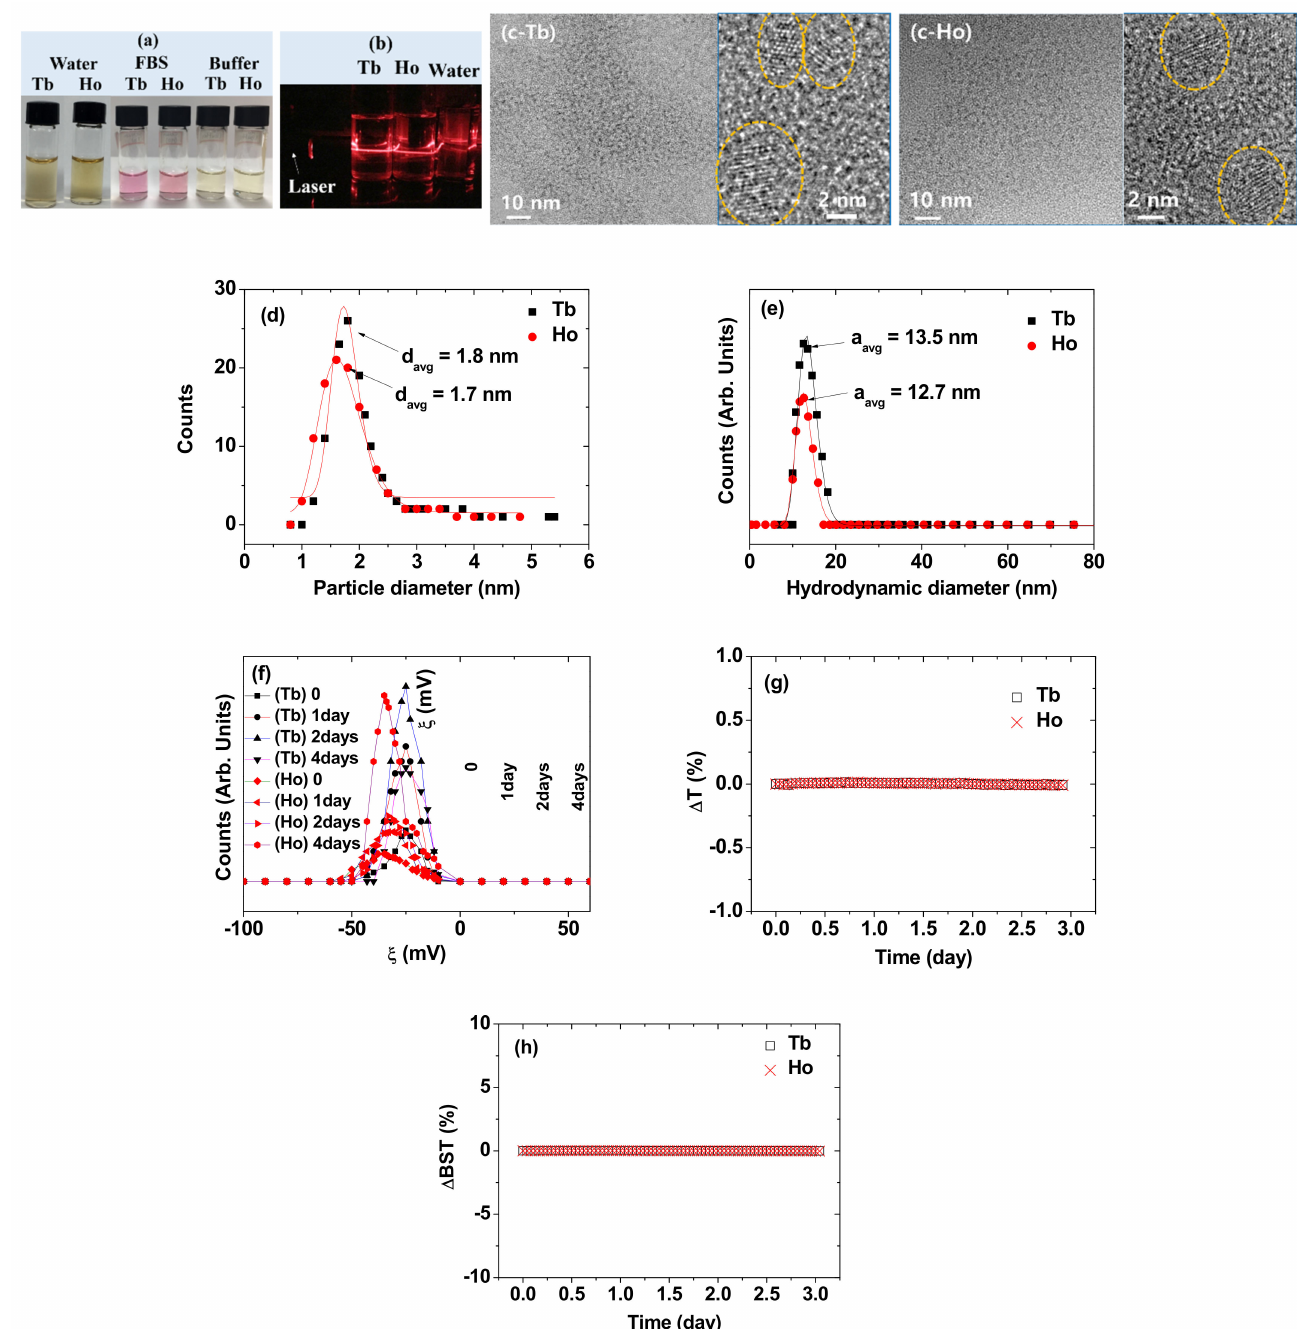
Figure 2. ( a ) Photographs of nanoparticle suspension samples in aqueous media, 10% FBS in RPMI1640 medium, and sodium acetate buffer solution (pH = 7.0), ( b ) laser light scattering (i.e., Tyndall effect) proving NP dispersions: laser light scattering was observed only for both solution samples whereas no light scattering was observed for the reference triple-distilled water, ( c ) HRTEM images at low (10 nm scale) and high (2 nm scale) magnifications: dotted circles indicate the PAA-coated Ln 2 O 3 NPs (Ln = Tb and Ho), ( d ) particle diameter distributions and log-normal function fits (the total number of NPs, N total = 133 for PAA-coated Tb 2 O 3 NPs and 111 for PAA-coated Ho 2 O 3 NPs), ( e ) hydrodynamic diameter distributions and log-normal function fits, ( f ) plots of zeta potentials ( ξ ) overtime (0, 1, 2, and 4 days) [insets are plot of ξ versus time (t)], ( g ) plots of ∆ T [= T(t) − T(0); T = height-averaged transmission of NIR beam] as a function of time, and ( h ) plots of ∆ BST [= BST(t) − BST(0); BST = height-averaged backscattering of NIR beam] as a function of time. Labels “Tb” and “Ho” indicate the PAA-coated Tb 2 O 3 and Ho 2 O 3 NPs,